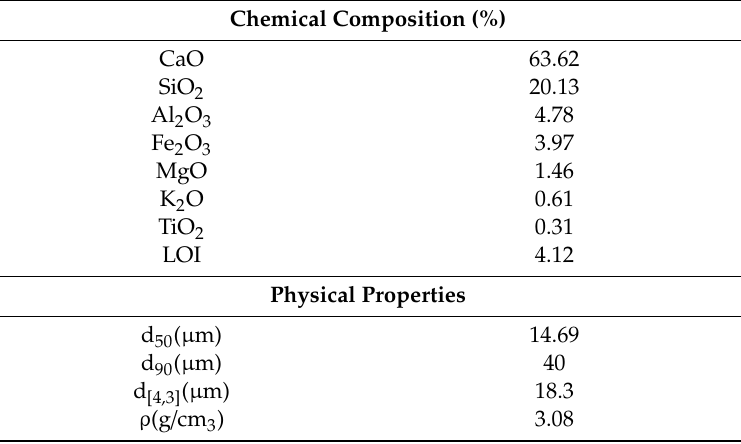
Table 4. The physical properties of